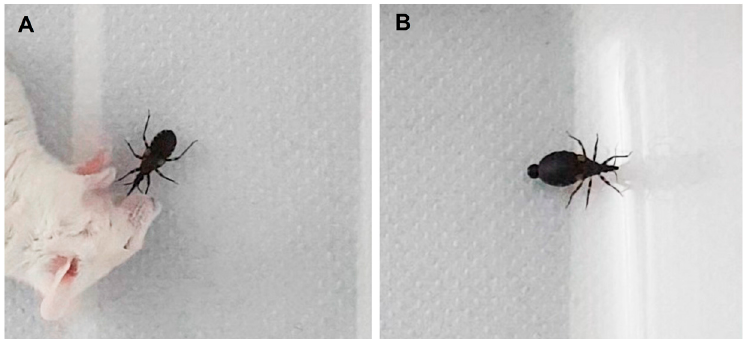
Figure 1. Images of Triatoma infestans during feeding and defecation activity. ( A ) Fifth nymphal instar of T. infestans biting an anesthetized Mus musculus during the recording of feeding behavior activity. ( B ) Fifth nymphal instar of T. infestans releasing dejections after the blood intake.